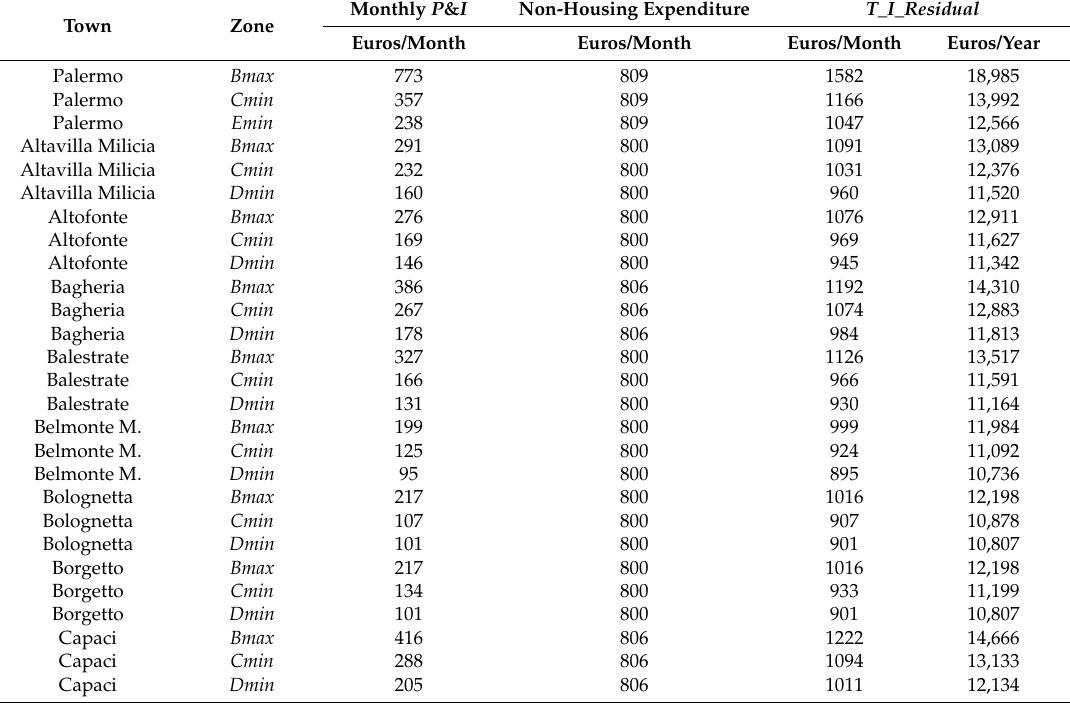
Table 4. Calculation of the T_I_residual in some towns of the NWS area (other data omitted). Town